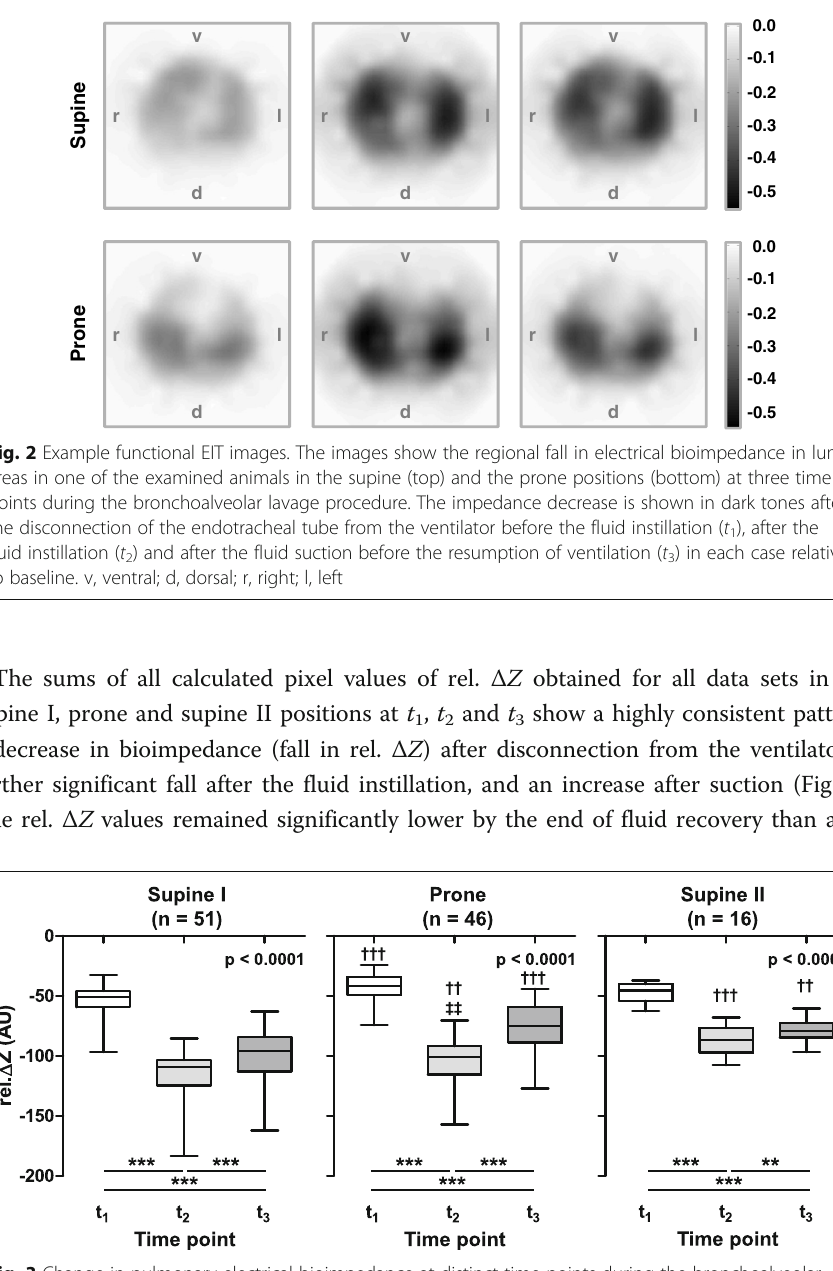
Fig. 3 Change in pulmonary electrical bioimpedance at distinct time points during the bronchoalveolar lavage procedure. The sums of all image pixel values of relative impedance changes (rel. Δ Z ) in arbitrary units (AU) are given after the disconnection of the endotracheal tube from the ventilator before the lavage fluid instillation ( t 1 ), after the fluid instillation ( t 2 ) and after the fluid suction before the resumption of ventilation ( t 3 ), in each case compared to baseline before the disconnection to ambient pressure. The data originate from lavages performed first in supine (left), then prone (middle) and final supine (right) positions (supine I, prone and supine II, respectively). The numbers of analysed bronchoalveolar lavages in each posture are given at the top of each diagram. p values given in the diagrams highlight the highly significant effect of the time point. The significance of differences between the individual time points was obtained from post analyses at ** p < 0.01 and *** p < 0.001. Significantly different values from the supine I position at corresponding time points are given as †† p < 0.01 and ††† p < 0.001 and from supine II position as ‡‡ p <